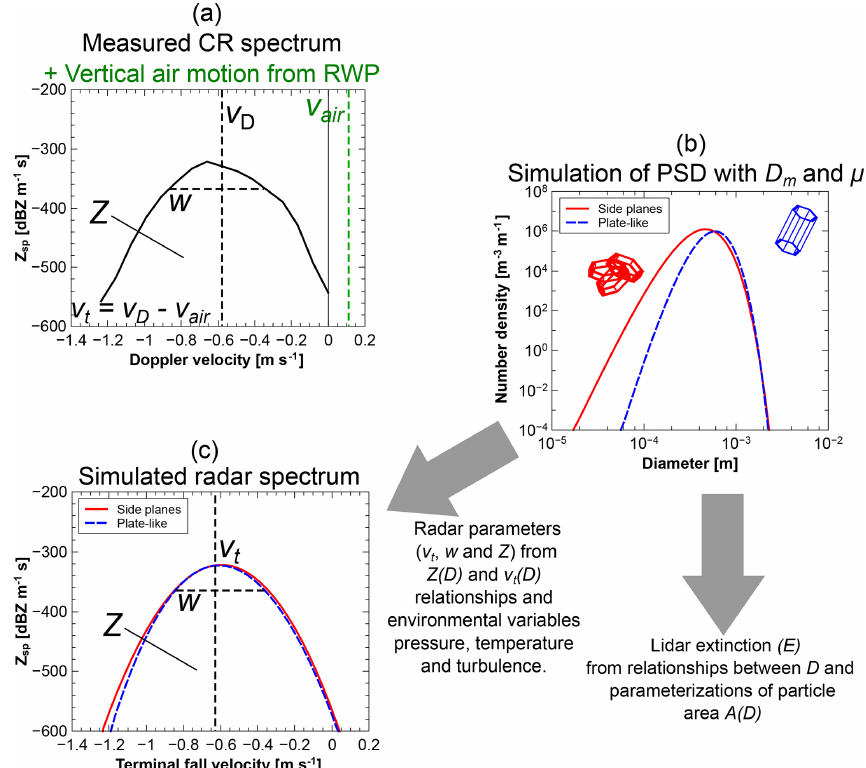
Figure 3. Illustration of the general idea of the retrieval. (a) Example CR Doppler spectrum measured at 4500m height with the CR at Lindenberg on 11 June 2015 at 19:00UTC (see Fig. 2) with spectral radar reflectivity ( Z sp (v) = Z(v)/(cid:49)v with Doppler spectrum grid length; (cid:49)v = 0 . 08ms − 1 ) for the first three moments, Z = (cid:82) Z(v) d v , v t and w . (b) PSDs for two different particle populations. (c) Simulated Z sp from both PSDs with the same moments as the measured variables.